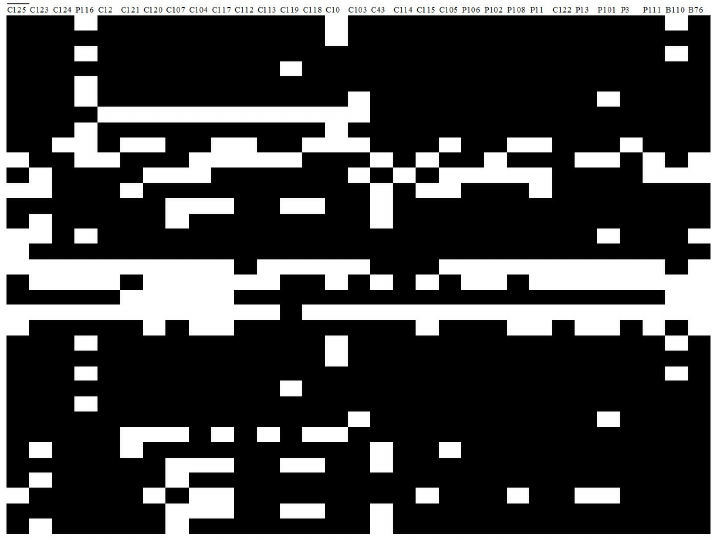
Fig. 3. Fingerprint derived from polymorphic markers representing level of polymorphism between 31 saffron selections (C: CITH; P: PAM and B: